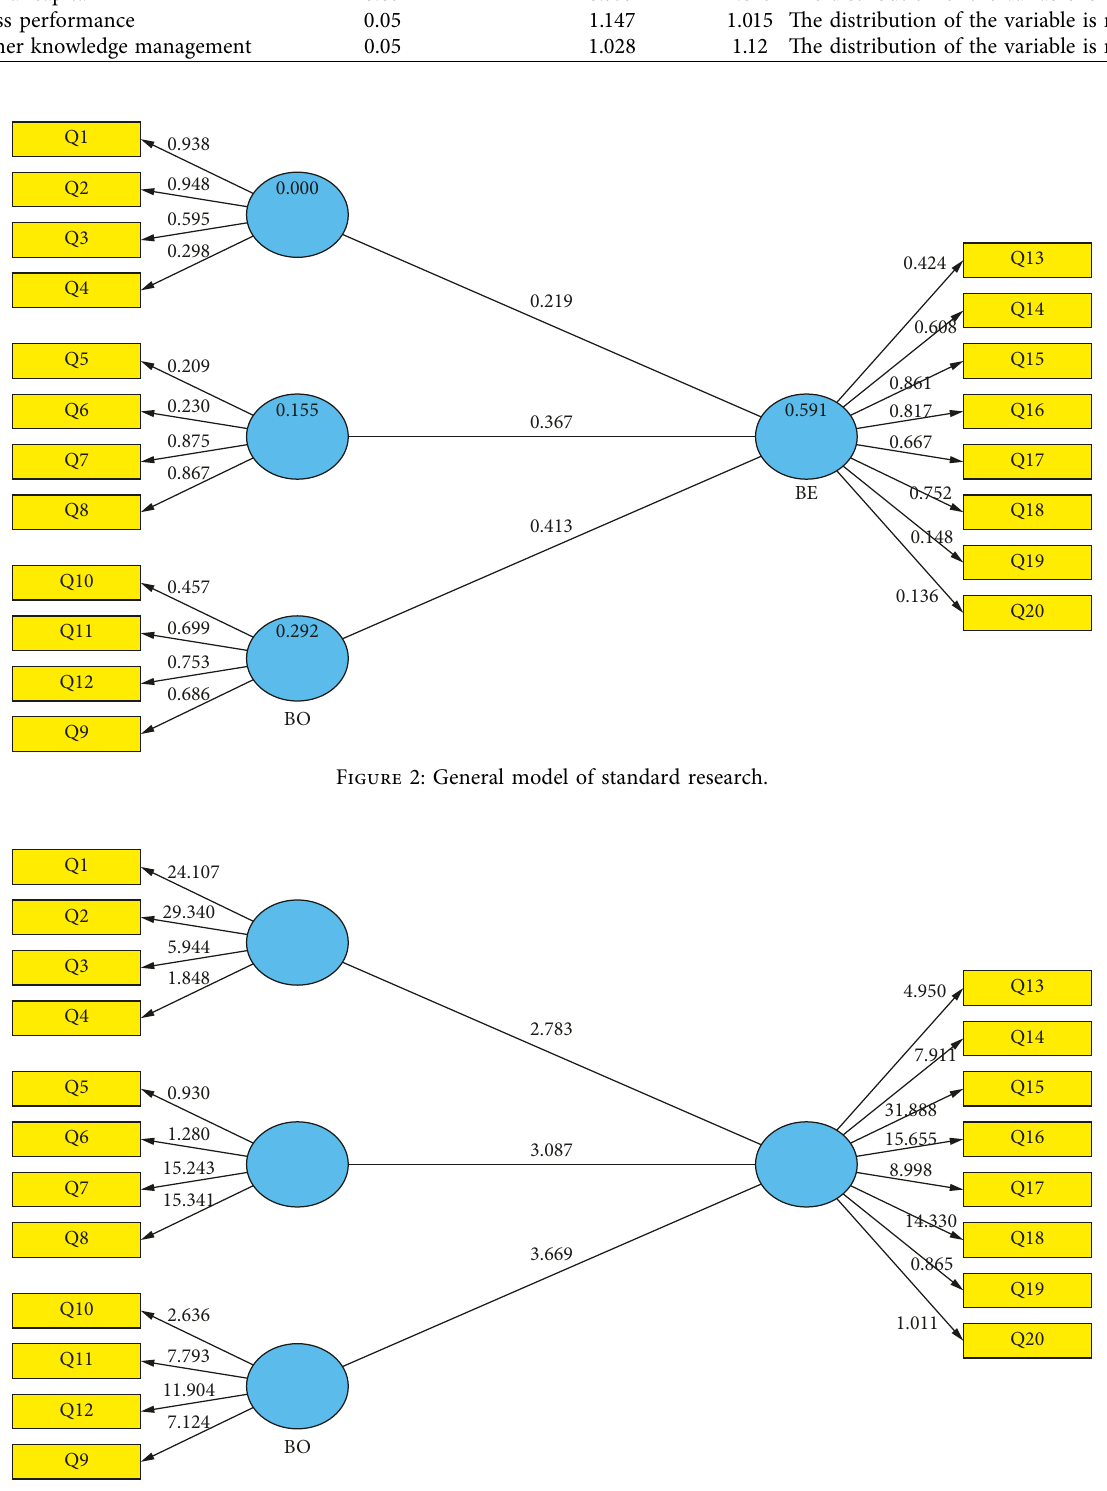
Figure 3: General model of research in a meaningful state.